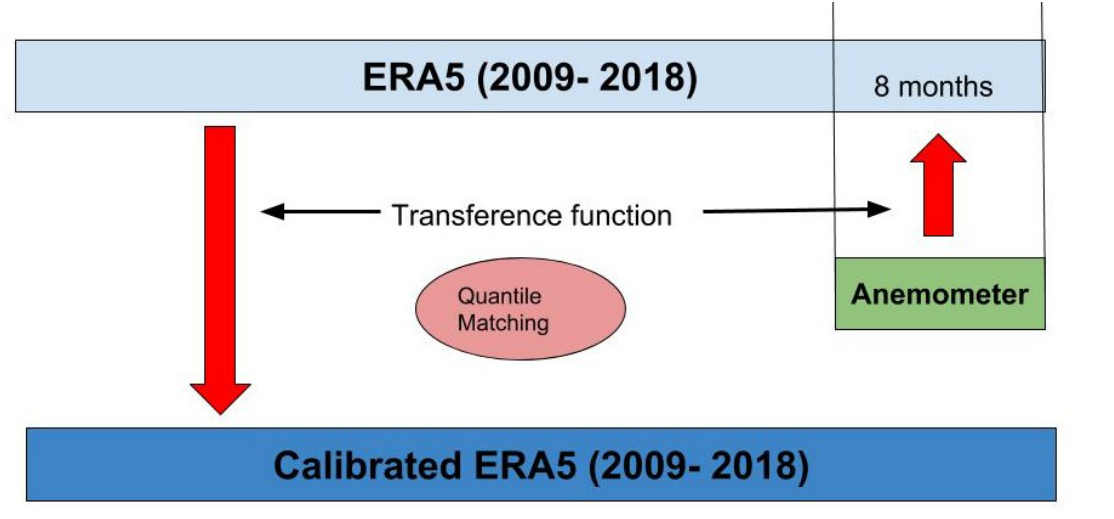
Figure 2. Calibration procedure and periods of the ERA5 and anemometer